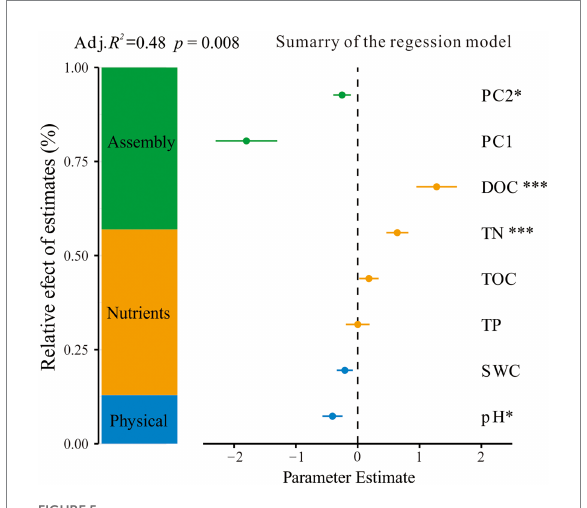
FIGURE 5 Effect of abiotic and biotic factors on total microbial abundance. Average parameter estimates (standardized regression coefficients) of model predictors, associated 95% confidence intervals, and relative importance of each factor, expressed as the percentage of explained variance. The adjusted (adj.) R 2 of the averaged model and the p -value of each predictor were given as: * p < 0.05; ** p < 0.01; *** p < 0.001. TOC, soil total organic carbon; DOC, dissolved organic carbon; TN, total nitrogen; TP, total phosphorus; SWC, soil water content. PC1 and PC2, the first and two axes’ scores of the principal component analysis for microbial community